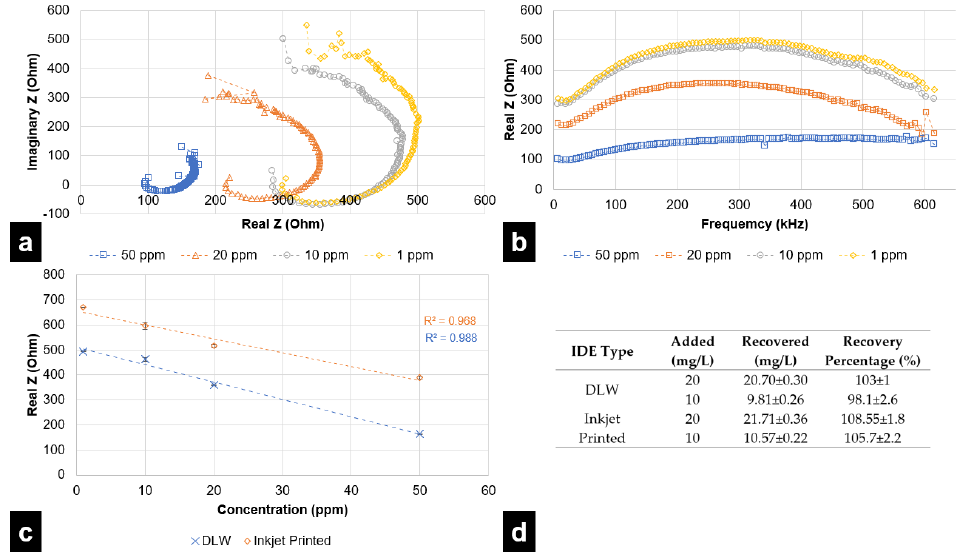
Figure 6. ( a ) Nyquist plot for nitrite sensing using the DLW-photolithography-based IDE sensor for different concentrations ( b ) real part of impedance vs. frequency plot for DLW-photolithography-based IDE sensor showing the nature of resistive impedance maximizing at 265 kHz ( c ) results derived from EIS analysis for nitrite concentration evaluation using inkjet printing-based IDE Sensor and DLW-photolithography-based IDE sensor in terms of resistive impedance vs. concentration ( d ) results for the analysis of tap water for detection via recovery of nitrite at different concentrations.